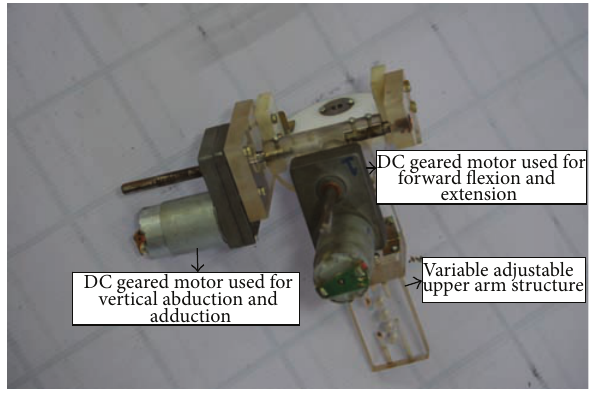
Figure 6: Manufactured model of glenohumeral joint.